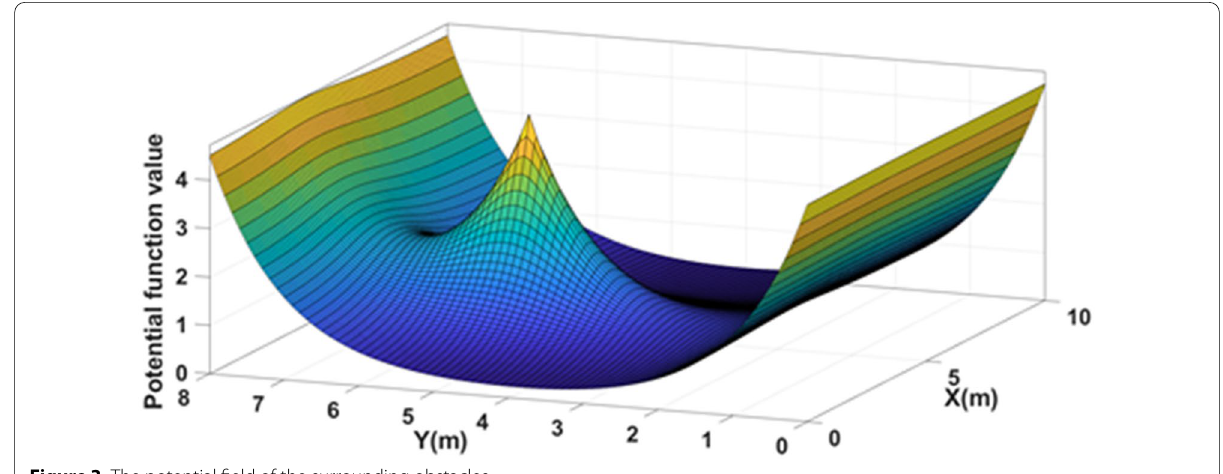
Figure 3 The potential field of the surrounding